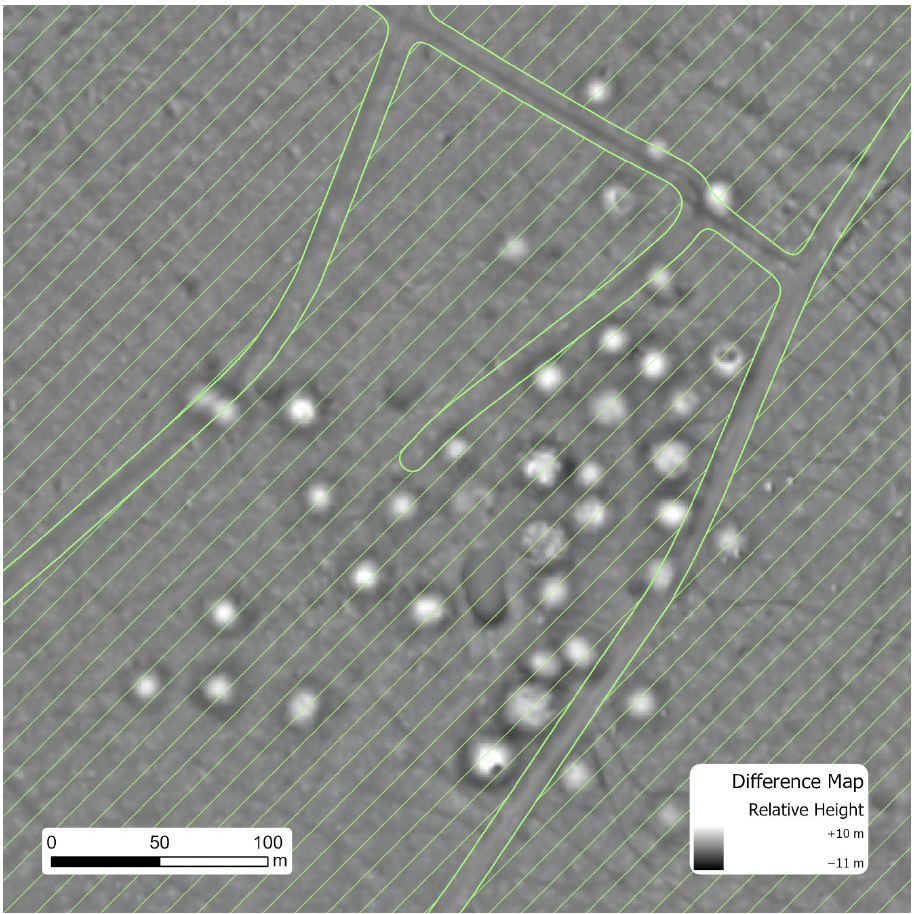
Figure 9. Some mounds in this cluster were removed from the results as they are cut by modern paths. Data source: [25]. Referring to the principles of OBIA, the output rectangles of the CNN were inter- preted as objects, for each of which, the mean and minimum Difference Map pixel values were calculated. Only those were further considered whose mean was ≥0 and ≤0.15 and whose minimum was ≥− 0.36 and ≤0.09. These thresholds were determined by manual in- terpretation of all 348 detections in this area (as reliable reference data are not available). Applying these thresholds only left 12 detections, 9 of which were already included in the database of archaeological records. Three represent probable new detections, meaning that precision is at least 75% while producing a manageable number of results. Including post classification, the CNN was applied to the whole DTM (Figure 4). De- tected mounds were analyzed regarding their spatial distribution around hollow ways. In an iterative process, mounds in areas defined by radii of 500 m to 3000 m were selected and their numbers assigned to the hollow ways (Figure 10).